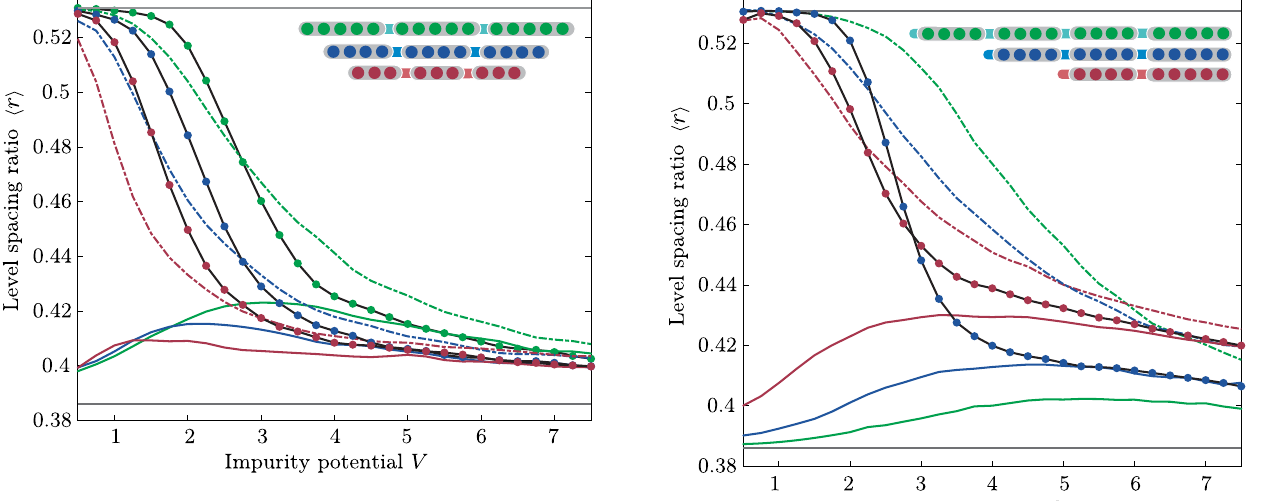
FIG. 7. Level spacing two impurities: mean ratio of energy level spacings h r i as a function of the impurity potential for Heisenberg chains of length L ¼ 11 , 14, 17 (red, blue, and green, respec- tively) with two impurities equally dispersed through the chain (black lines with circles). The dash-dotted lines show the level spacing ratio h r i for the effective model where the impurities are frozen. The full lines result from folding the spectrum of the effective model, resulting from the four possible energies associated with the conserved charge of the impurities.